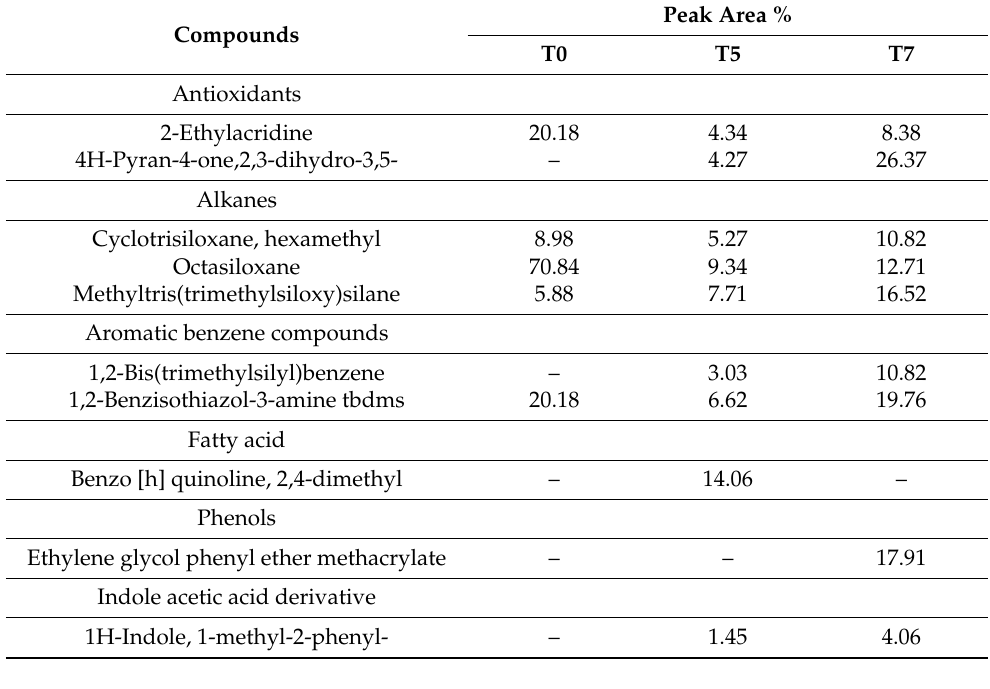
Table 3. GCMS analysis tomato pericarp in treatments T0, T5 and T7 (T0—Control, T5—S150 mM, T7—T5 + T6).